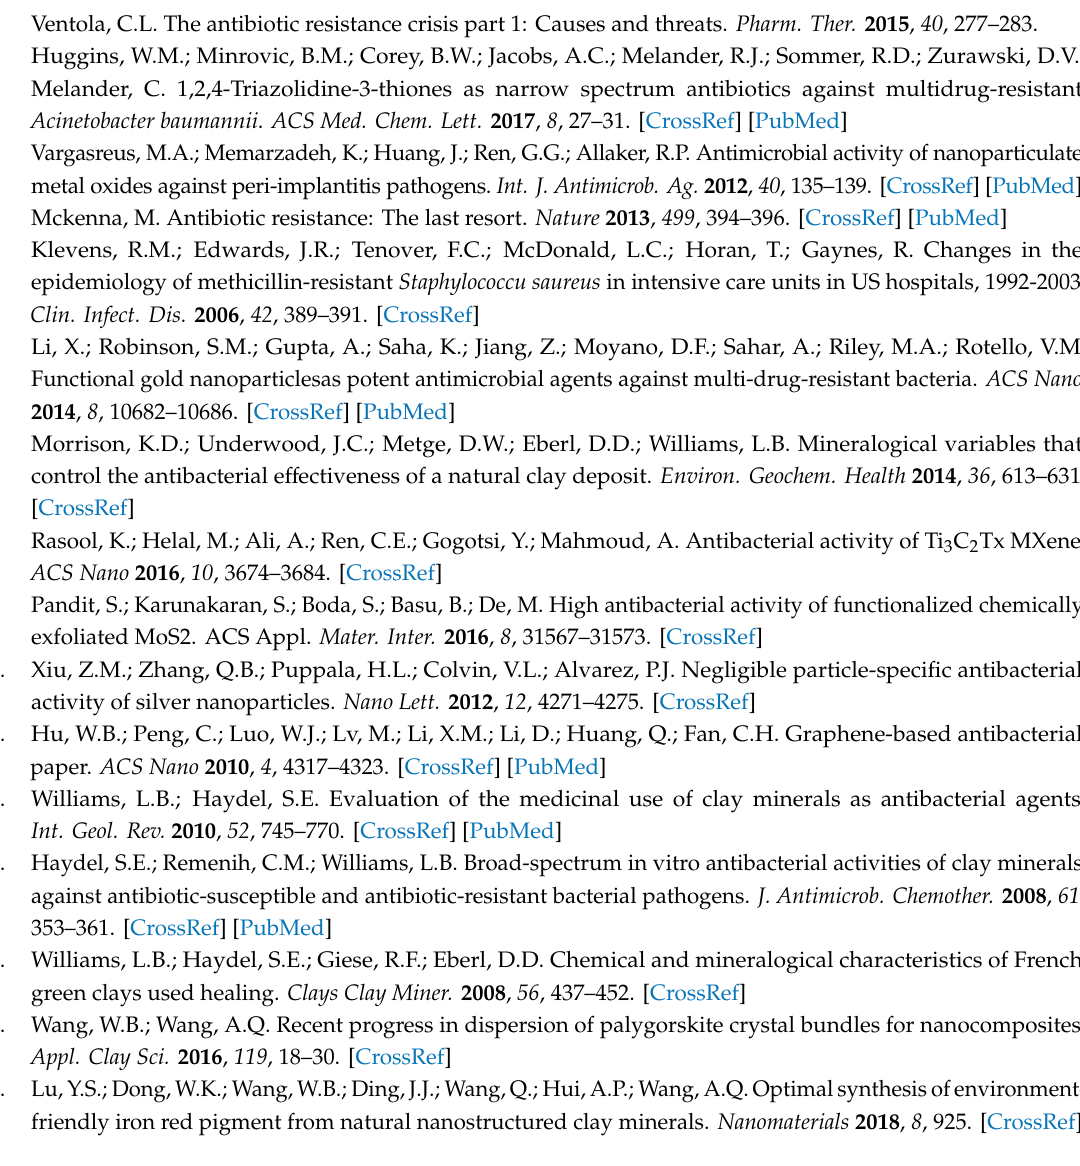
PAL, Figure S4: Zeta potential of PAL, ZnO / PAL, ZnO / PAL-1 and ZnO / PAL-2, the pH was 6.3 (aqueous solution), Figure S5: (a) Blank control, (b) positive control of E. coli , E. coli treated by PAL with various concentrations of (c) 50 mg / mL, (d) 20 mg / mL, (e) 10 mg / mL, (f) 1 mg / mL, Figure S6: (a) Blank control, (b) positive control of S. aureus , S. aureus treated by PAL with various concentrations of (c) 50 mg / mL, (d) 20 mg / mL, (e) 10 mg / mL, (f) 1 mg / mL, Table S1: The MIC values of ZnO / PAL nanocomposites prepared by di ff erent content of Span 40 against E. coli and S. aureus , Table S2: The MIC values of ZnO / PAL nanocomposites prepared by di ff erent content of Tween 20 against E. coli and S. aureus , Table S3: The ZnO loading of ZnO / PAL-1 and ZnO / PAL-2 determined by AAS. Author Contributions: A.H. conducted the experiment and wrote the original draft preparation, S.D. and Y.K. characterized and evaluated the material properties and Y.Z. and A.W. designed the experiment and revised the